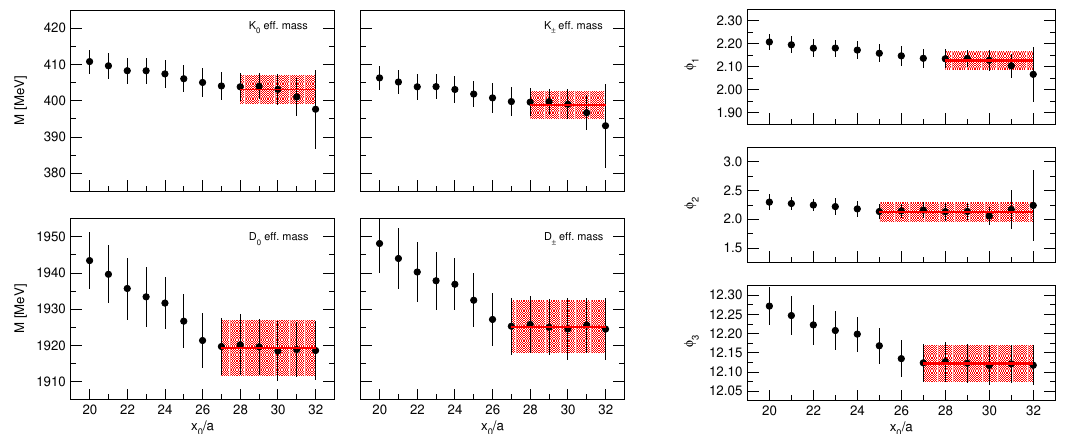
Figure 4 . Meson effective masses and effective φ observables for the ensemble A380a07b324+RW1 , together with the selected plateaux and the fits to a constant. Values in MeV are obtained by using the reference value (8 t 0 ) 1 / 2 = 0 . 415 fm